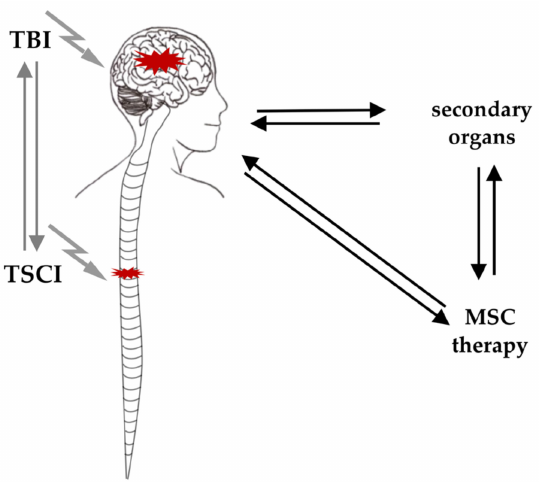
Figure 2. TSCI and TBI interaction occurs directly or indirectly via secondary organs. TBI and TSCI can influence each other directly via neurogenic interactions or indirectly via their impact on secondary organs, tissues and signalling cascades. MSC therapy in this context may influence TSCI or TBI directly or by their impact on these secondary alterations. In concomitant TSCI and TBI the role of MSC treatment is unclear, and whether the established options for one injury affect the other also remains unclear. Abbreviations: MSC = mesenchymal stem cell, TBI = traumatic brain injury, TSCI = traumatic spinal cord